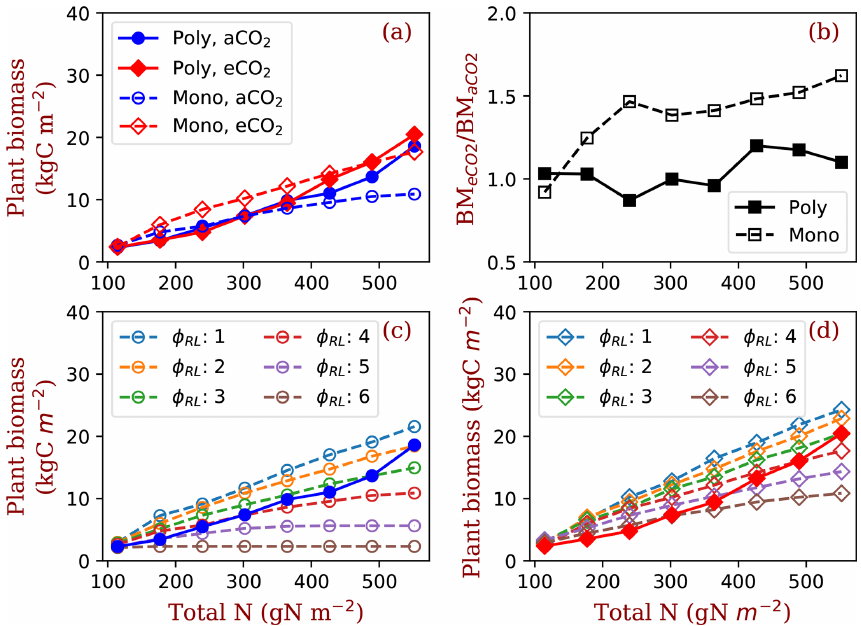
Figure 7. Plant biomass responses to elevated [CO 2 ] and nitrogen. Panel (a) shows the equilibrium plant biomass (means of simulated plant biomass from model run year 1400 to 1800) in polyculture runs and monoculture runs (only ϕ RL = 4 is shown as an example). Panel (b) shows the ratio of simulated plant biomass at elevated [CO 2 ] to ambient [CO 2 ] for both competition and monoculture runs. Panels (c) and (d) show the comparisons with monoculture runs with ϕ RL increasing from 1 to 6 at ambient (c) and elevated [CO 2 ] (d) . The closed symbols with solid lines represent polyculture runs. The open symbols with dashed lines represent monoculture runs ( ϕ RL ranges from 1 to 6). ϕ RL is the fixed ratio of fine root area to leaf area of a particular strategy. a CO 2 : 380ppm; e CO 2 :